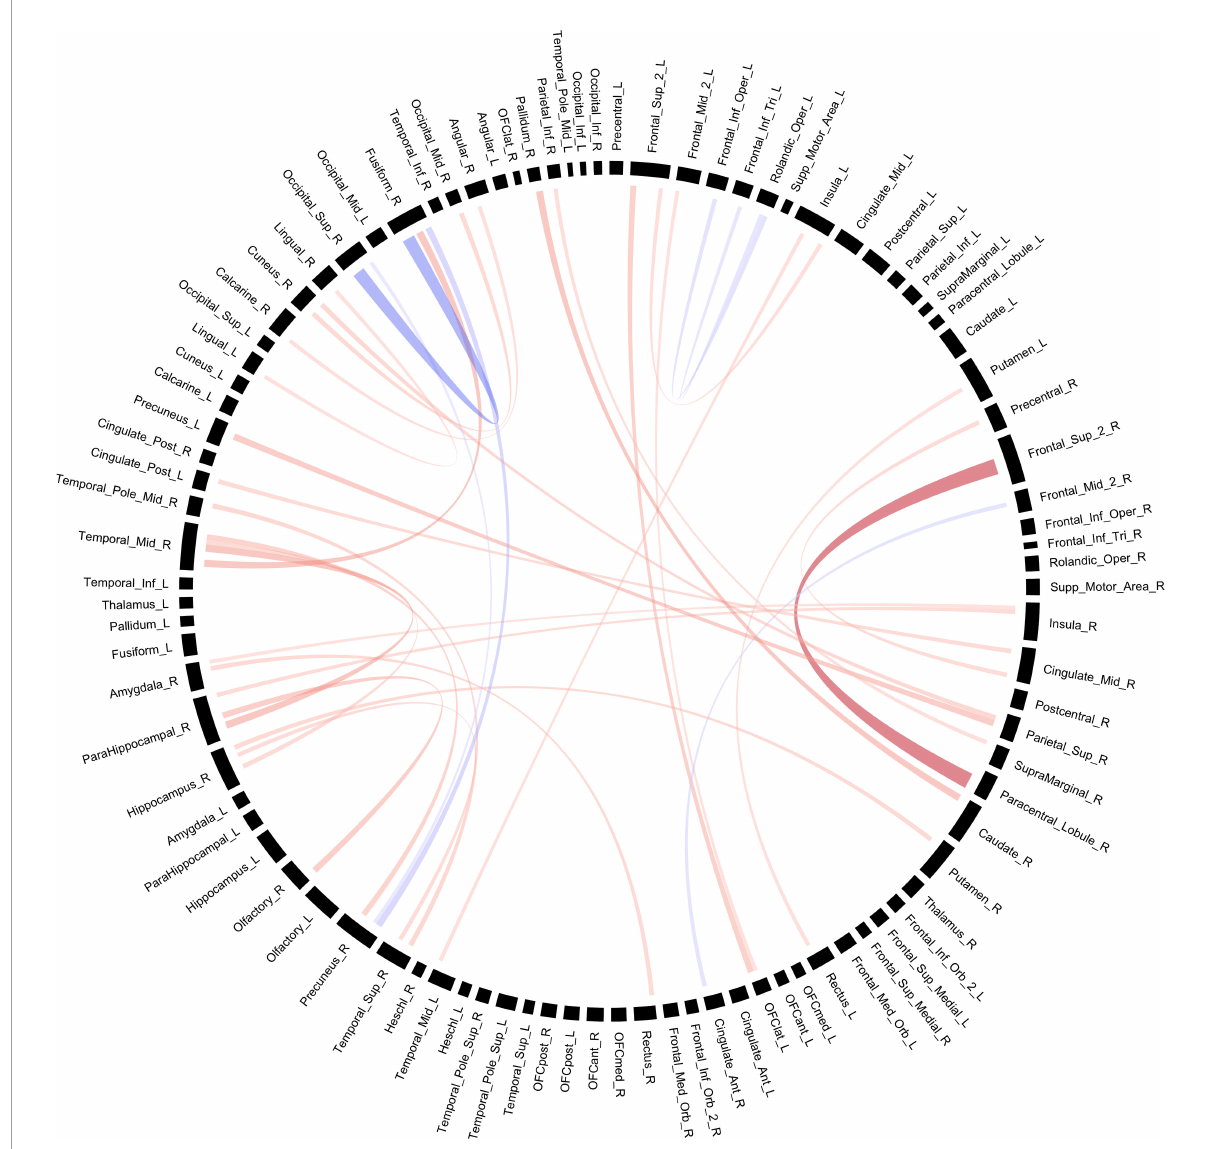
FIGURE2 Structural connectivity between regions of interest based on fiber count. Red bands indicate a greater connectivity in the POE group while blue bands indicate greater connectivity in the control group. Band thickness is determined by the t-stat